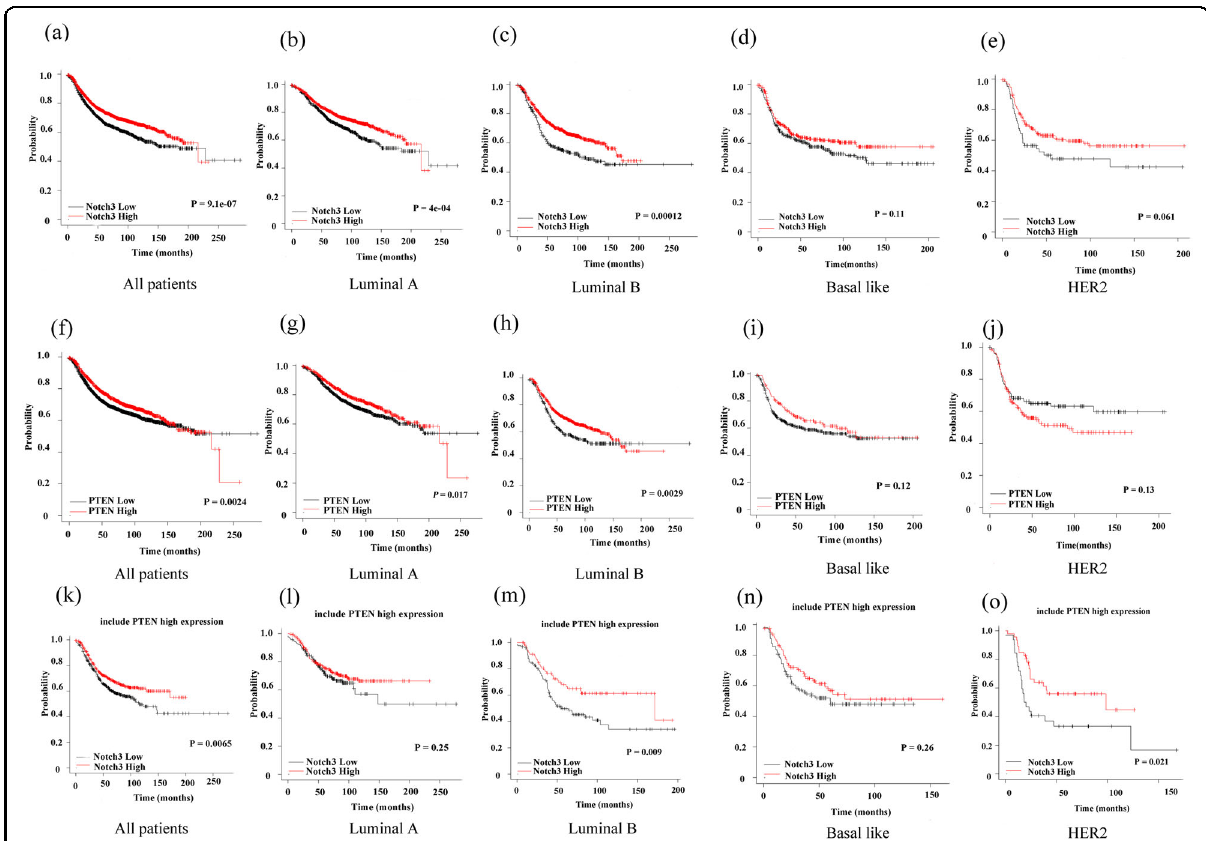
Fig. 6 High Notch3 and PTEN mRNA expression predicts a better RFS in breast cancer patients. High expression of Notch3 ( a – e ) or PTEN ( f – h ) resulted in a better RFS among different breast cancer subtypes. PTEN levels had no effect on RFS among the basal-like ( i ) and HER2-positive ( j ) subtypes. A better RFS was observed for breast cancer patients expressing both high Notch3 and high PTEN levels with all patients, luminal B or HER2-positive subtypes ( k , m , o ) but not the luminal A or basal-like subtype ( l , n